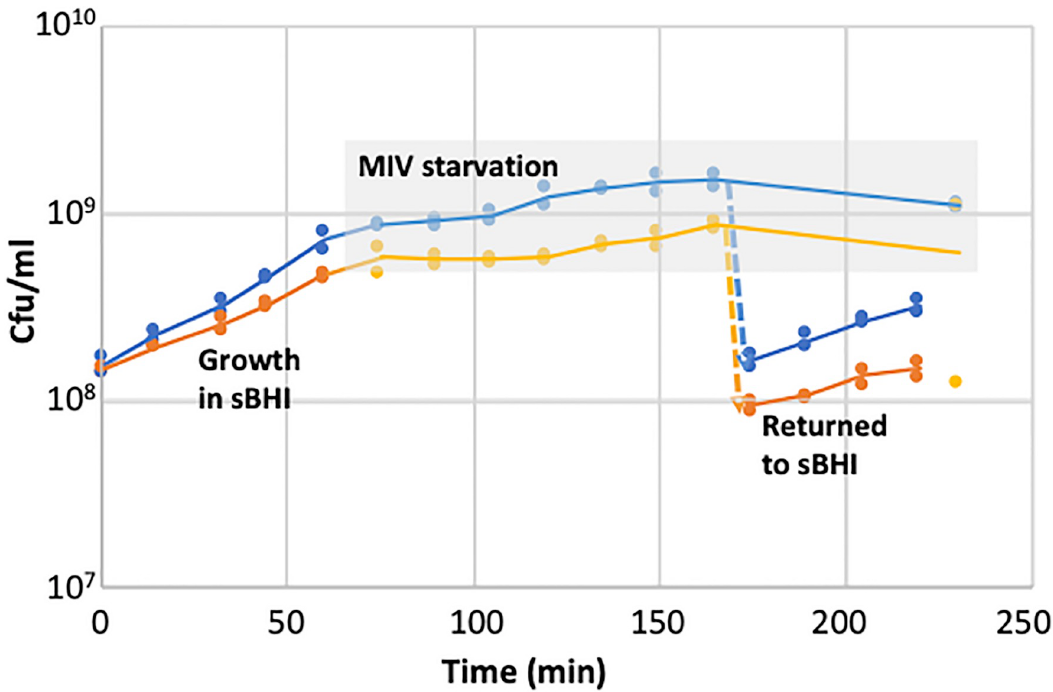
Fig 5. Growth of H . influenzae wildtype and Δ toxA cells before, during and after competence induction. Two independent cultures of log-phase cells in sBHI were transferred to MIV at t = 65 min; a portion of each MIV culture was diluted 10-fold into sBHI at t = 170 min. The grey-shaded area indicates samples taken from MIV cultures. Blue: KW20, orange: Δ toxA . Figure E in S1 File shows the corresponding OD600 values.